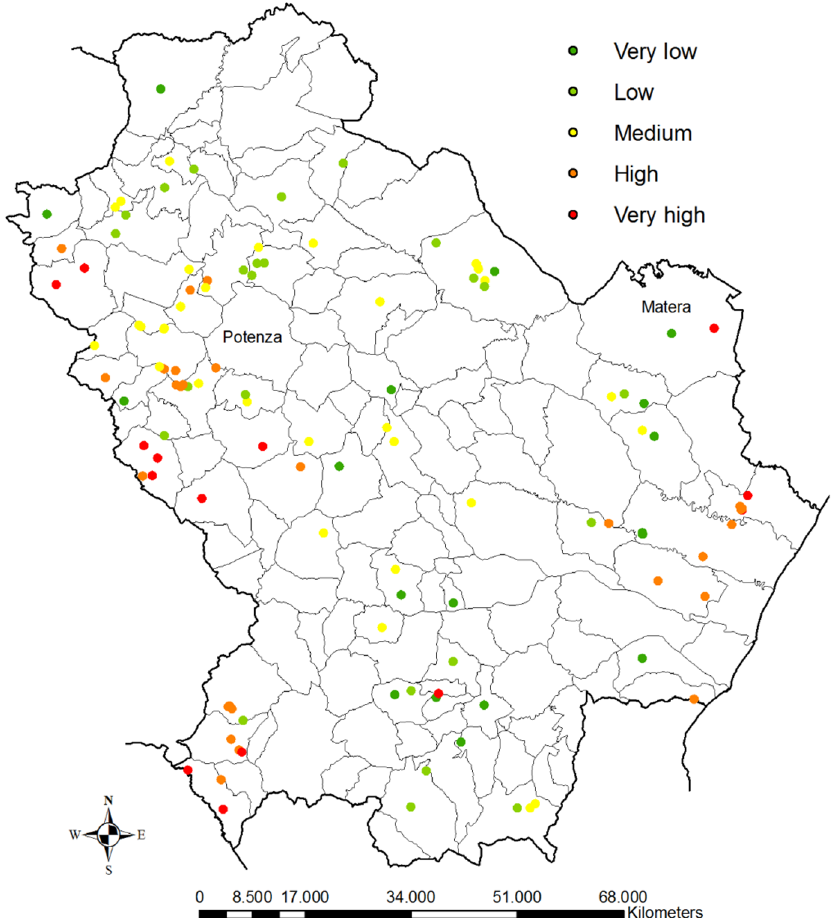
Figure 17. Map of dumpsite integrated vulnerability in the Basilicata region (fuzzy